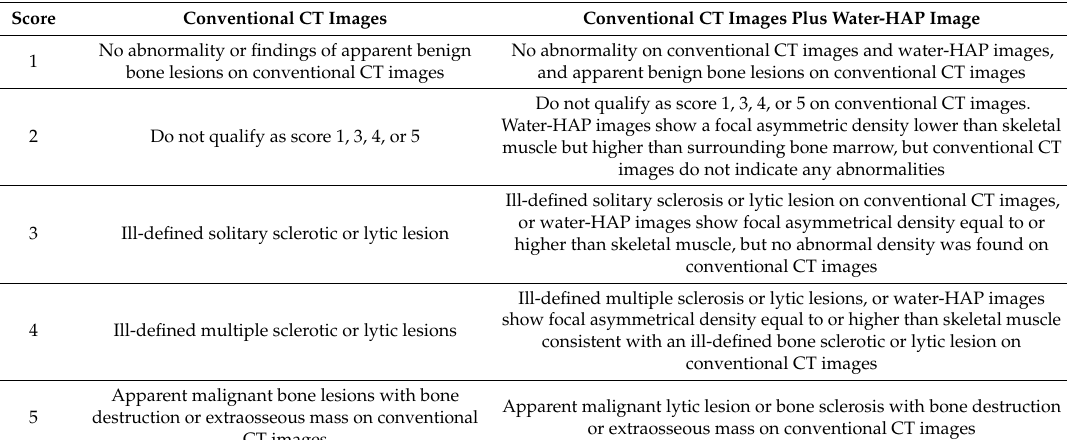
Table 1. Visual evaluation score for bone lesions in conventional CT images and conventional CT images plus water-HAP